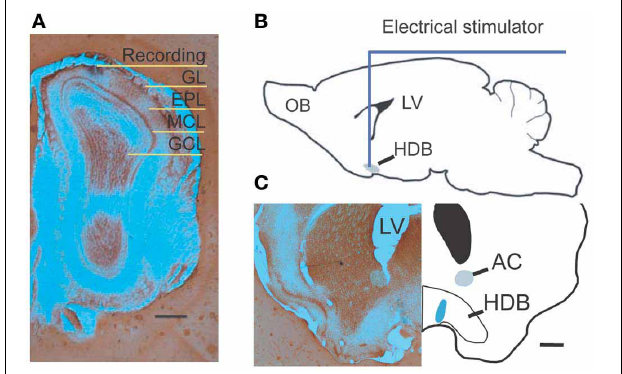
FIGURE 1 | Experimental diagram. (A) Photograph shows a recording location with pontamine sky blue located in the superficial external plexiform layer. (B) A drawing shows the location of NDB stimulation; the HDB is highlighted. (C) An examplar stimulating location shows blue ion deposits from stimulating electrode visualized by potassium ferrocyanide. Scale bar = 250 μ